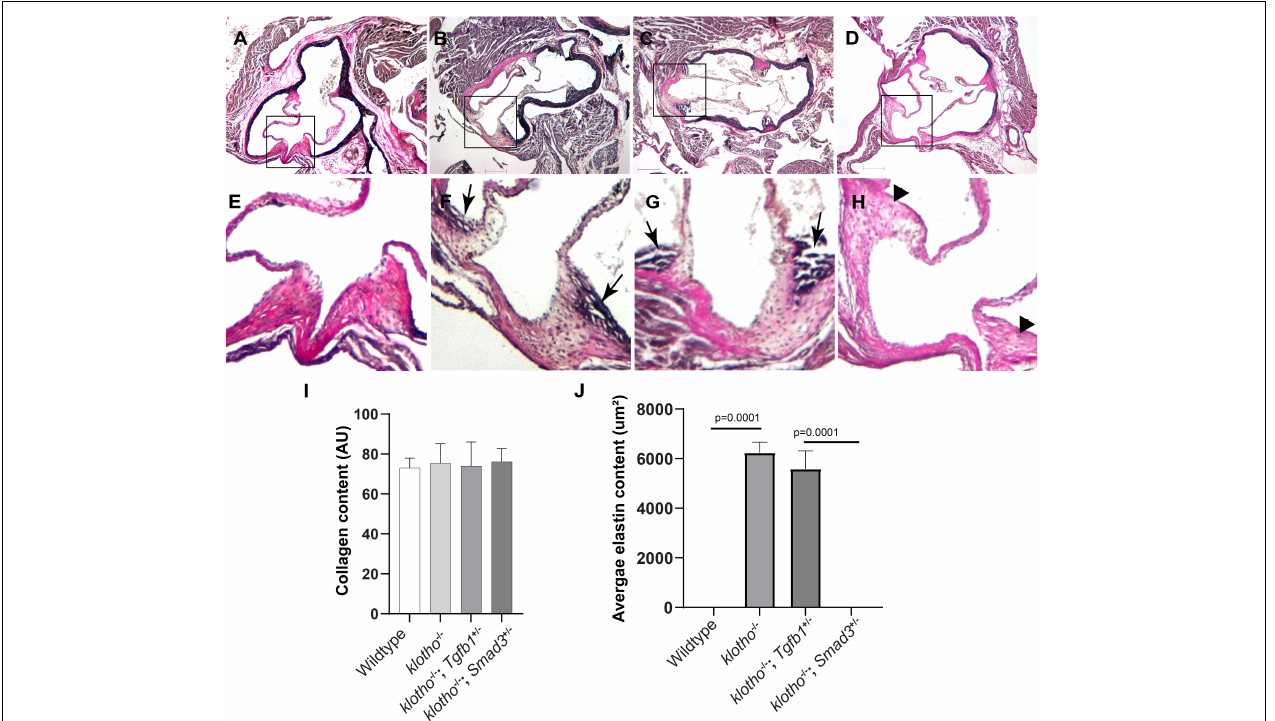
FIGURE 3 | Effect of Tgfb1 and Smad3 heterozygous deletion on collagen and elastin fibers in the aortic valve of 10–12-week-old Kl − / − mice. (A–H) Verhoeff-Van Gieson (VVG) staining of tissue sections through the aortic valve and annulus of wild-type (A,E) , Kl − / − (B,F) , Kl − / − ;Tgfb1 ± (C,G) , and Kl − / − ;Smad3 ± (D,H) mice. Magnified images of the boxed area (A–D) are given in (E–H) . Arrows indicate the presence of abnormal elastin fibers in Kl − / − (F) and Kl − / − ; Tgfb1 ± (G) mice. VVG stains elastin in black and collagen fibers in red color. (I) Histogram showing total collagen content in the aortic valve, including leaflets, annulus, and AV hinge. Quantification of collagen fibers content was done by measuring the intensity of collagen staining on multiple serial sections from each animal per group by using NIH-Image J software. Values indicate mean ± SD ( n = 5). (J) Histogram showing the average area containing the elastin fibers in the AV hinge. Quantification of elastin fibers content was done by measuring the average area in the AV hinge with elastin staining on multiple serial sections from each animal per group by using NIH-Image J software. Values indicate mean ± SD ( n = 5), and significant “ p -values” were given on the top of histograms. Scale bars: (A–H) 200 µ m.